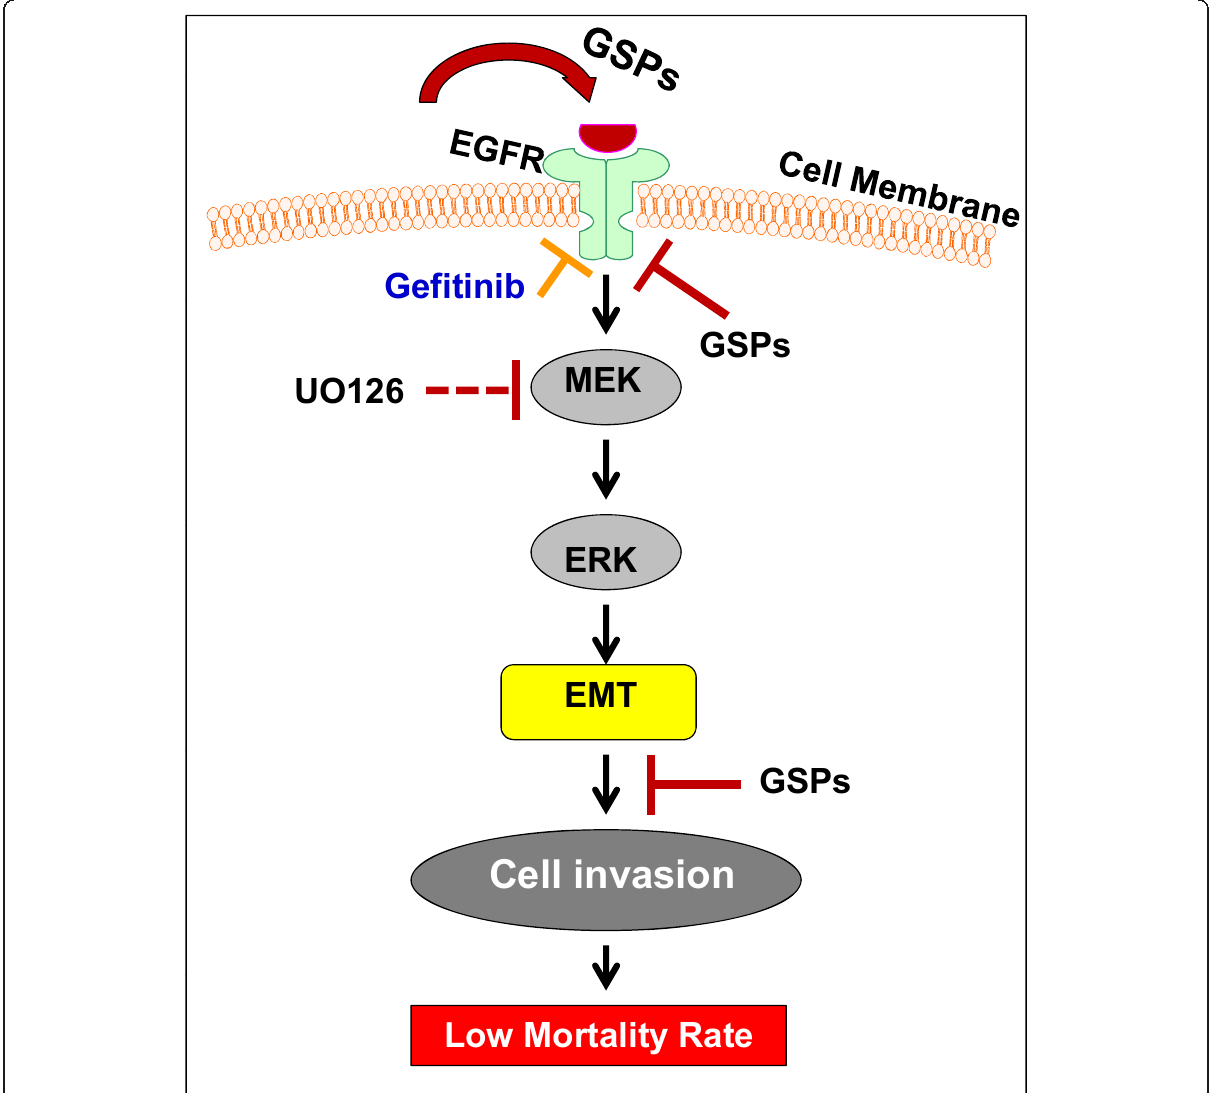
Figure 6 Summary of GSPs action on the prevention of SCC13 cell invasion . GSPs inhibit the expression levels of EGFR in human cutaneous head and neck squamous cell carcinoma cells, which plays a critical role in inactivation of ERK1/2 and reversal of epithelial-to- mesenchymal transition and that leads to inhibition of cell invasion